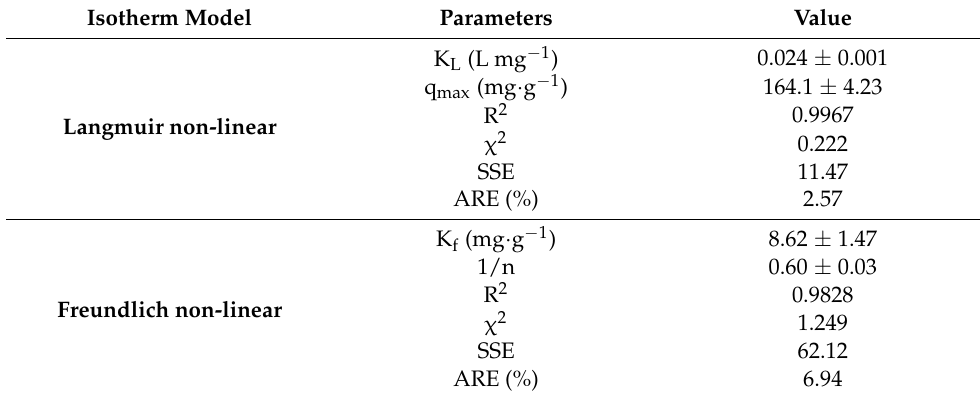
Table 3. Adsorption isotherms model constants and the corresponding error functions.